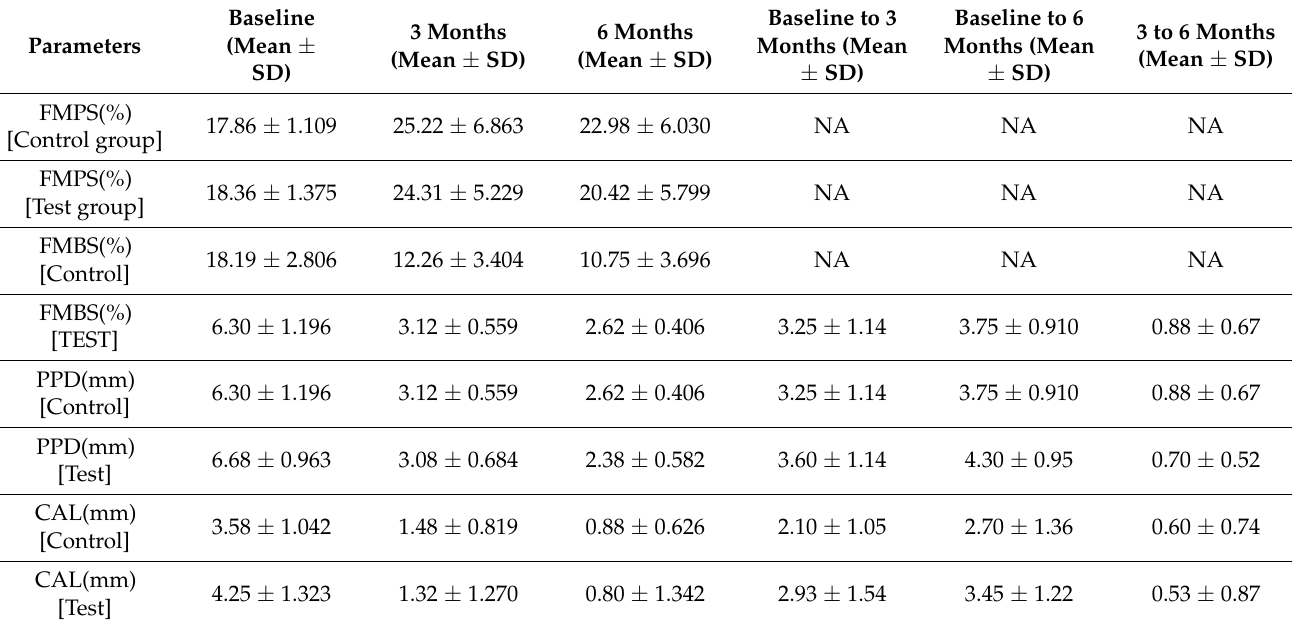
Table 1. Descriptive statistics for test and control groups.